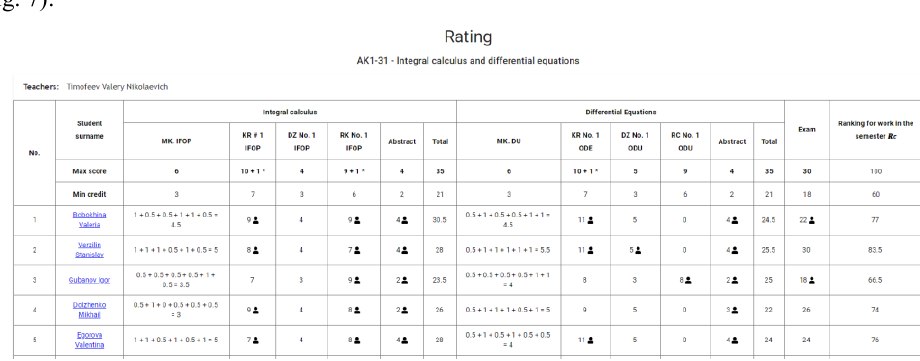
Fig. 7. Rating of a study group for the course "Integrals and Differential